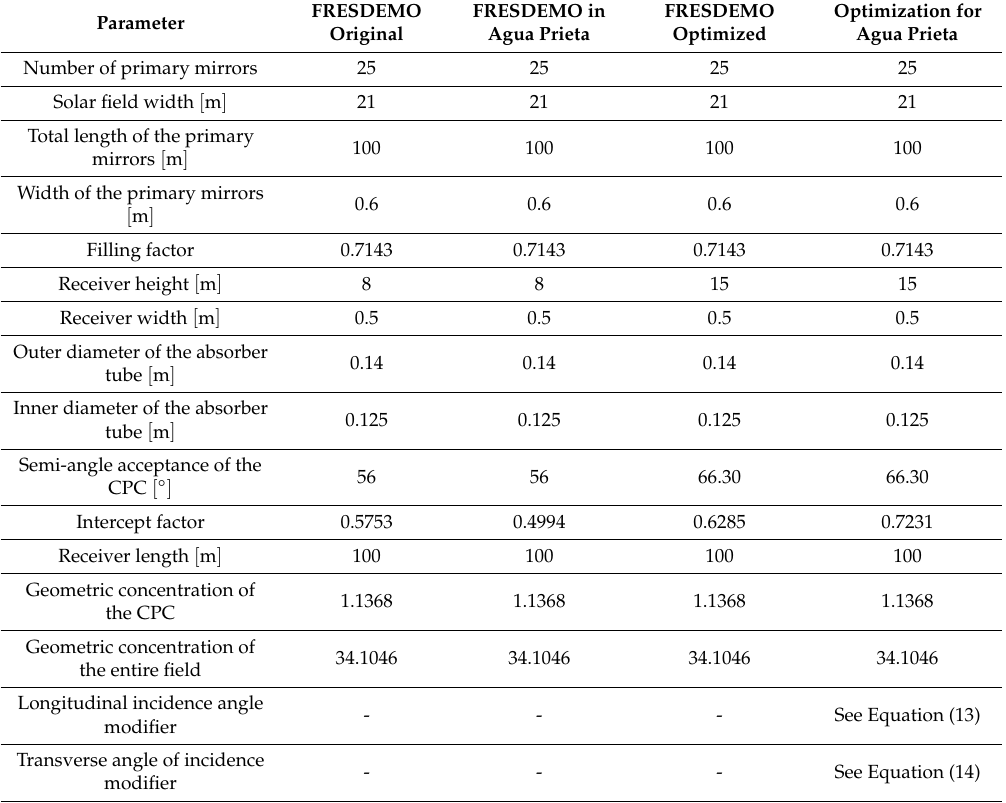
Table 4. Comparison of the description of the Fresnel reflectors and the optimized solar field for Agua Prieta,